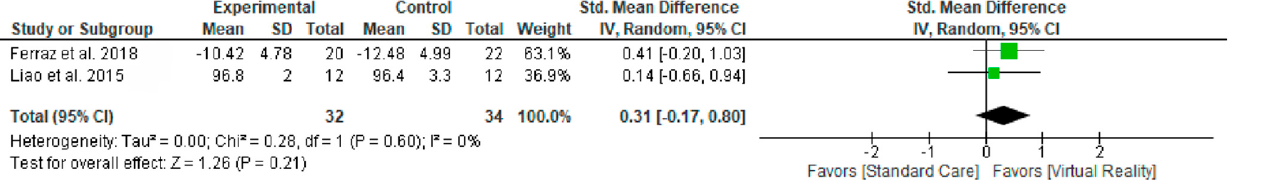
Figure 5. Comparison 2. Virtual reality versus standard care treatment. Outcome: balance. A green block indicates the weight assigned to the study, and the horizontal line depicts the confidence interval. A black rhombus shows the overall result [37,39].